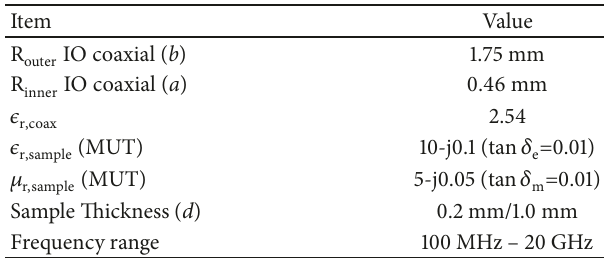
Table 1: Basic data for the test